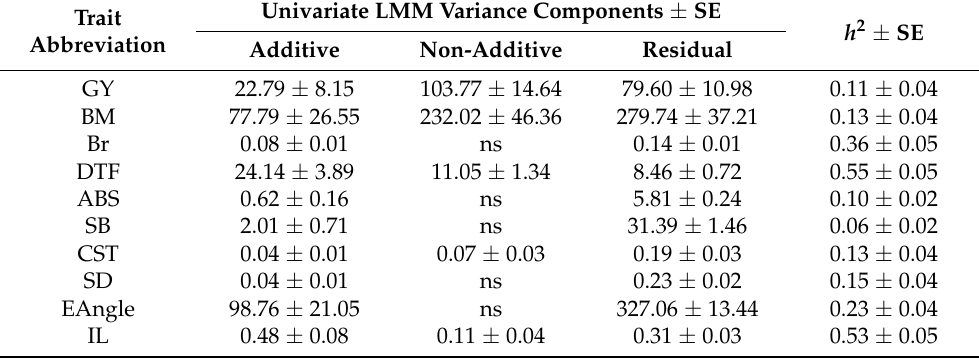
Table 1. Additive genetic, non-additive genetic, and residual variance components from univariate linear mixed model analyses (LMM) for 10 traits scored in Cycle 3 of the experimental field pea breeding